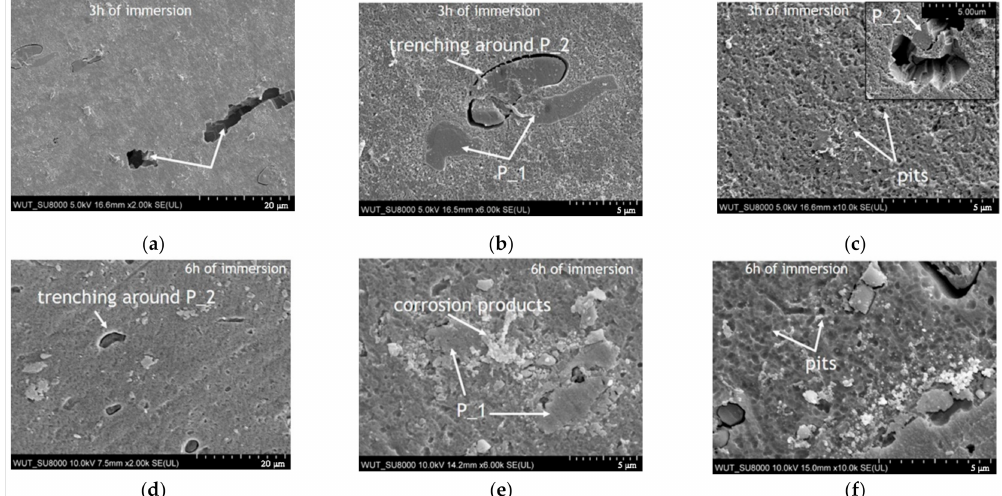
Figure 8. Post-corrosion observations of AA5754 in the deformed area (B) after immersion under open-circuit conditions. Images taken after 3 h of immersion showing: ( a ), the propagation of crystallographically-grown pits, ( b ), the trenching around Si-rich (P_2) particles, and ( c ), a high-magnification image of tiny pits. Images taken after 6 h of immersion showing: ( d ), trenching around Si-rich (P_2) particles, ( e ), corrosion products around Fe-rich (P_1) particles, and ( f ), the formation of tiny